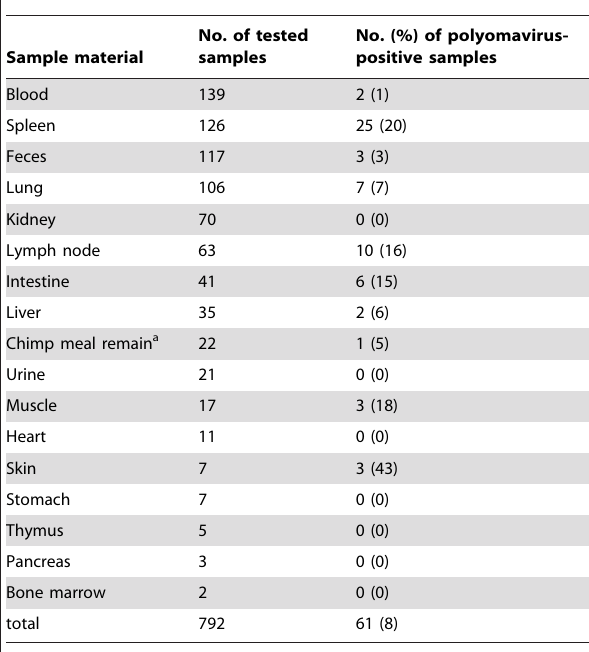
Table 1. Sample material and polyomavirus content.